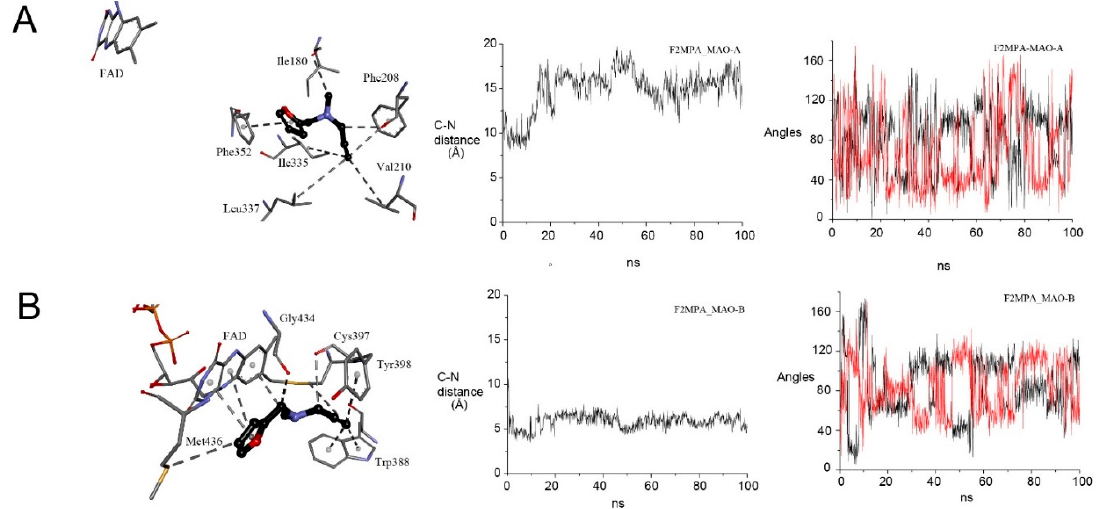
Figure 12. MD analysis of the interaction of F2MPA with MAO-A ( A ) and MAO-B ( B ). Left : the location of F2MPA is towards the entrance loop in MAO-A ( A , top ), but for MAO-B ( B , bottom ) is tight up against the flavin in the aromatic cage. Hydrophobic interactions are shown as gray dotted lines. For MAO-B, the key interactions that contribute to forming the stable complex involve hydrophobic interactions with FAD (by pi-pi T shaped interactions), the residues Trp388, Tyr398 (by pi-alkyl interactions) and Cys397 (by alkyl-alkyl interactions). Ligand is also H-bonded (CH ... O) to Gly434, and a pi-sulfur interaction occurs with Met436. Middle : C α P-N5 distance. Right : the angles C-H-N5 for the hydrogens on C α at the propargyl side of the amine.